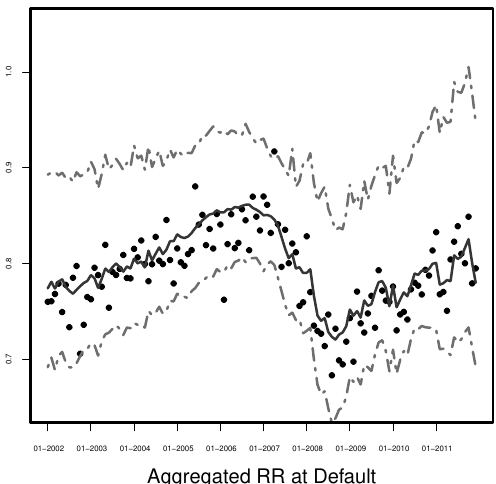
Figure 18. Monthly aggregated recovery rates with 99% prediction interval (grey dot-dash line) and the mean of the predictions (grey solid line) at the time of default for the reduced model with